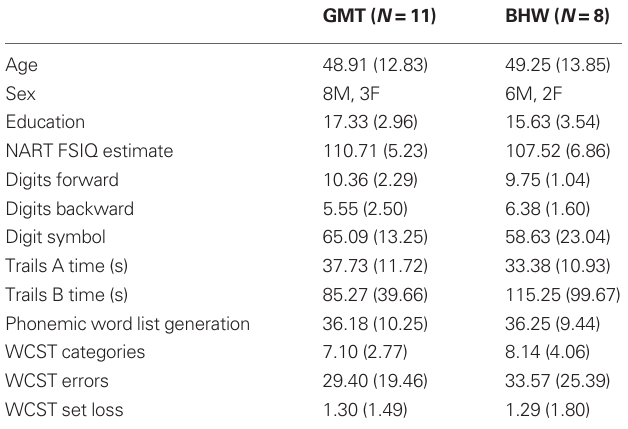
Table 1 | Demographic and neuropsychological test